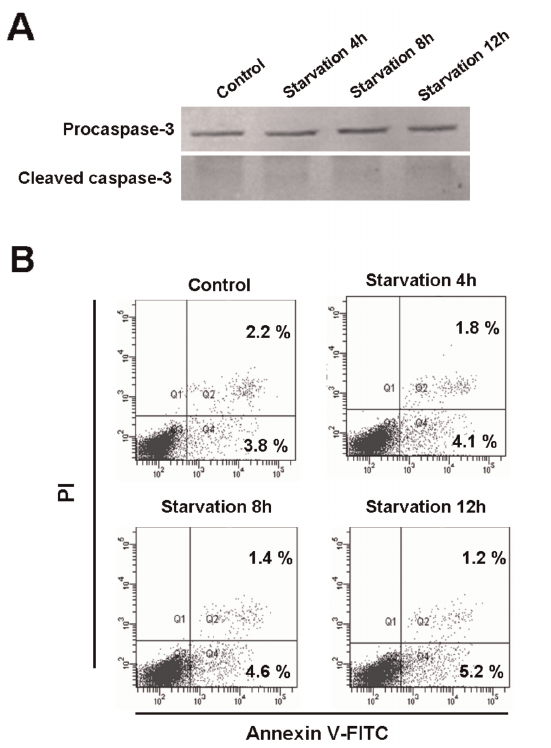
Figure 3. CLIC4 upregulated and nuclear translocated in U251 cells under starvation conditions. (A) Western blot analysis of nuclear CLIC4 and total CLIC4 expressions in U251 cells incubated with EBSS for 4 h, 8 h and 12 h. (B) Densitometric analysis of normalized nuclear CLIC4 and total CLIC4 protein levels. Standard error represents three independent experiments. Data were presented as mean 6 SD. * P , 0.05 versus control group.